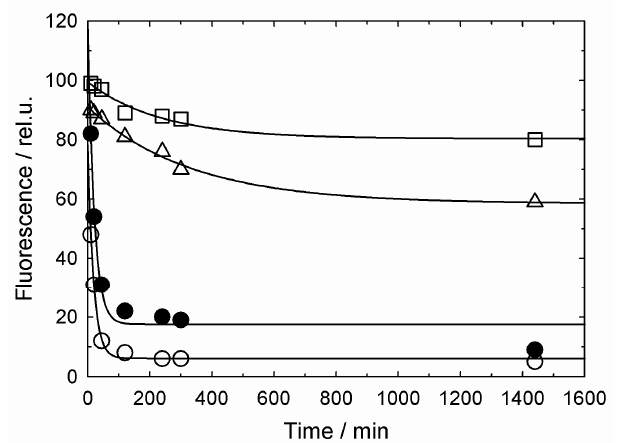
Figure 2. Time-dependent presence of denatured fluorescein-labeled lysozyme in the supernatant (after centrifugation) during the protein incubation in the presence of 5 mM DTT without (o) and with equimolar GroEL ( □ ) in the presence of 10 mM Mg-ADP ( ∆ ) and a two-fold molar excess of GroES ( ● ). Solid lines represent an exponential approximation.